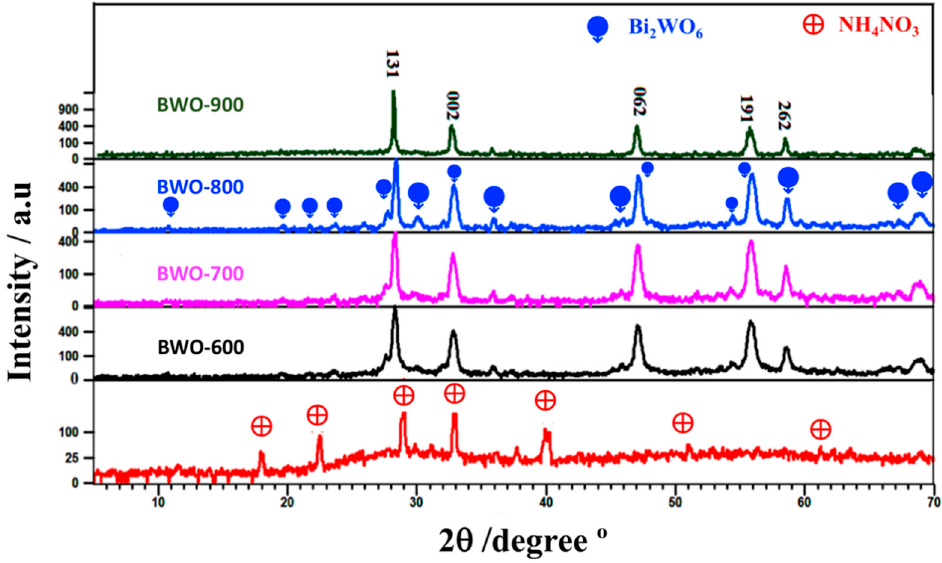
Figure 1. Diffraction profiles of the prepared materials.